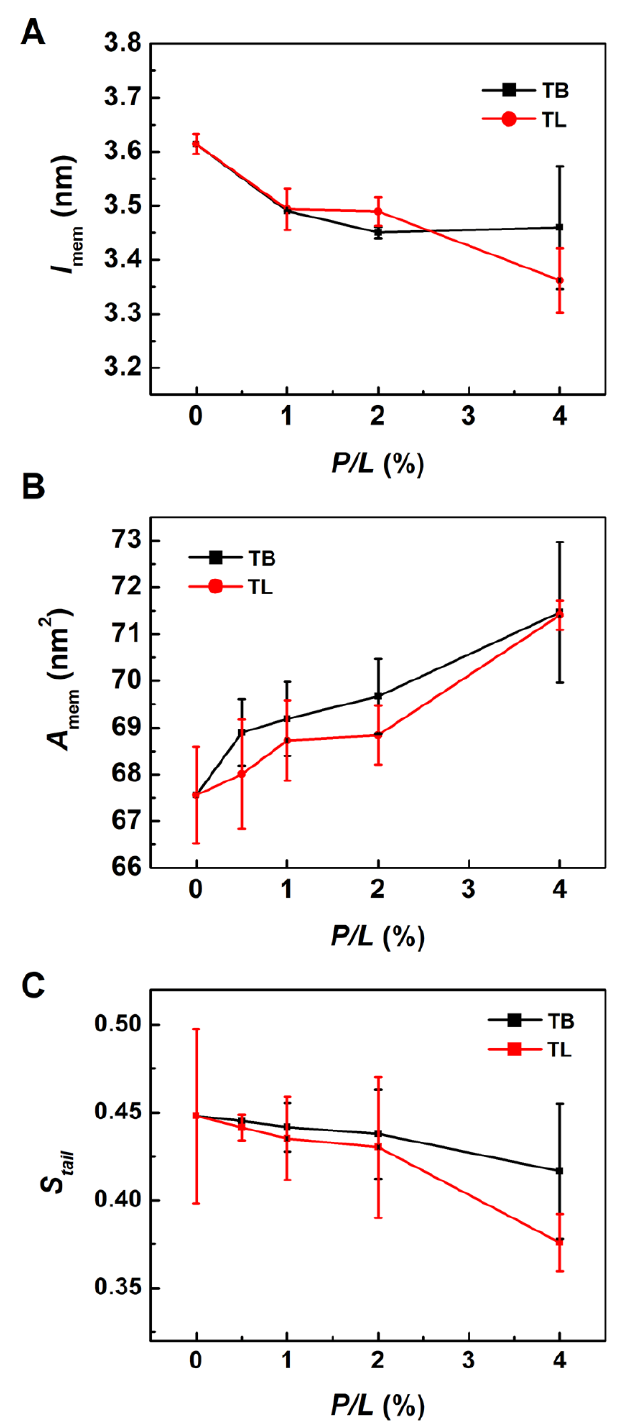
Figure 4. Changes of ( A ) membrane thickness l mem , ( B ) membrane area A mem and ( C ) lipid orien- tation order induced by TB and TL at various peptide concentrations. Data were obtained from AAMD simulations.